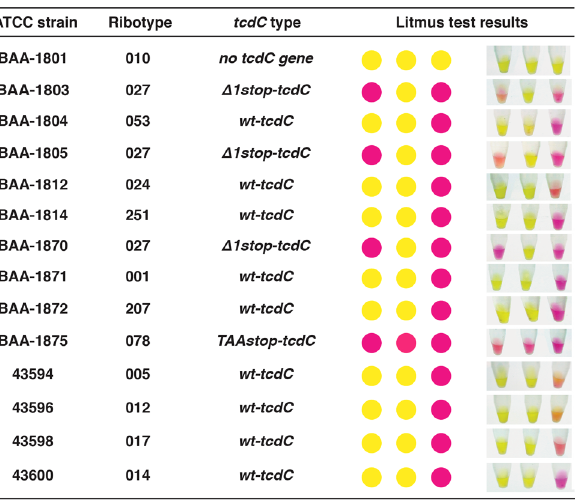
Figure 4. PCR-litmus test with genomic DNA from 14 different C. difficile strains. The tcdC genes from all the strains were sequenced and their nucleotide sequences were compared with database entries by using PubMLST program. Ribotype of each strain is provided by ATCC. The photographs of test were taken at 30